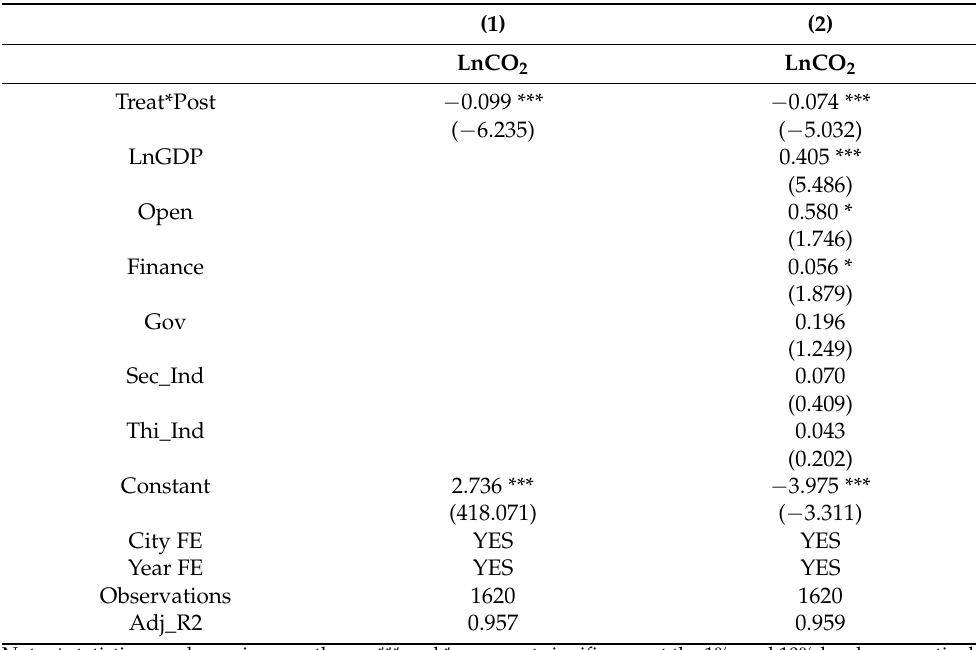
Table 3. The effect of city cluster policy on CO2